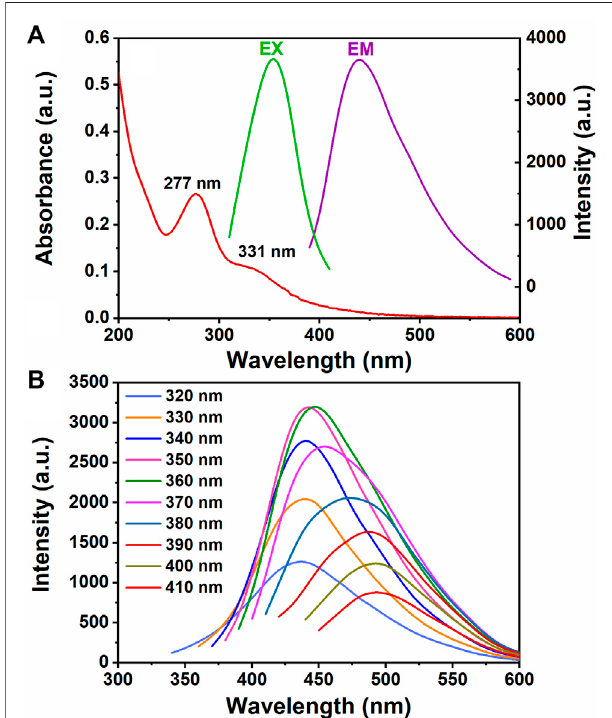
FIGURE 4 | (A) UV – Vis absorption spectra of CQDs and the excitation/ emission fl uorescent spectra of CQDs. (B) Fluorescent emission spectra of CQDs at different range of excitation